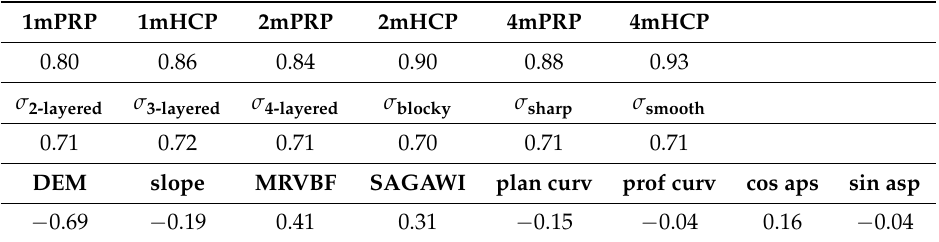
Table 3. Pearson’s r correlation coefficient between the target variable (i.e., peat thickness) and the EC a , σ and topography-based predictor variables.